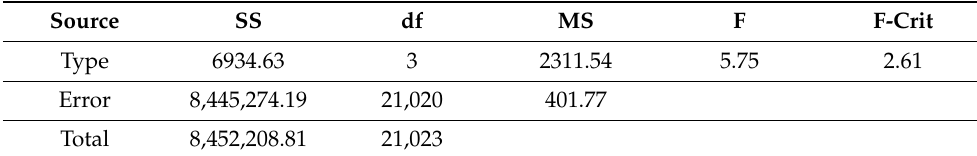
Table 6. One-way analysis of variance on forecasting results based on the historical data of PM2.5 in space (GY & STRR), combined with historical data of meteorological factors in different regions as input data of the network. In this table, SS is the sum of squares and df is the degrees of freedom. The MS (mean squares) is the estimate of variance given by SS/df.